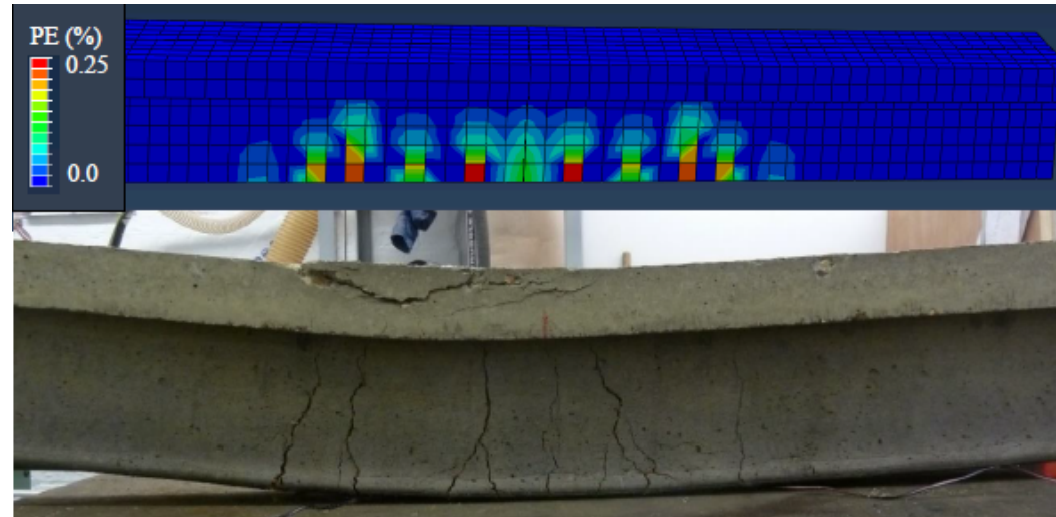
Figure 13. Comparison of cracking and plastic strain between model and experiment for S1-C.